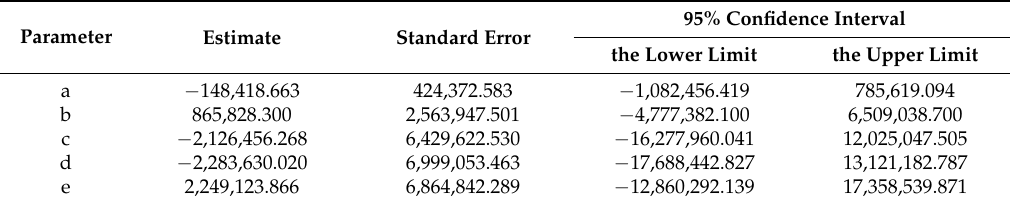
Table 2. Parameter estimates of price and